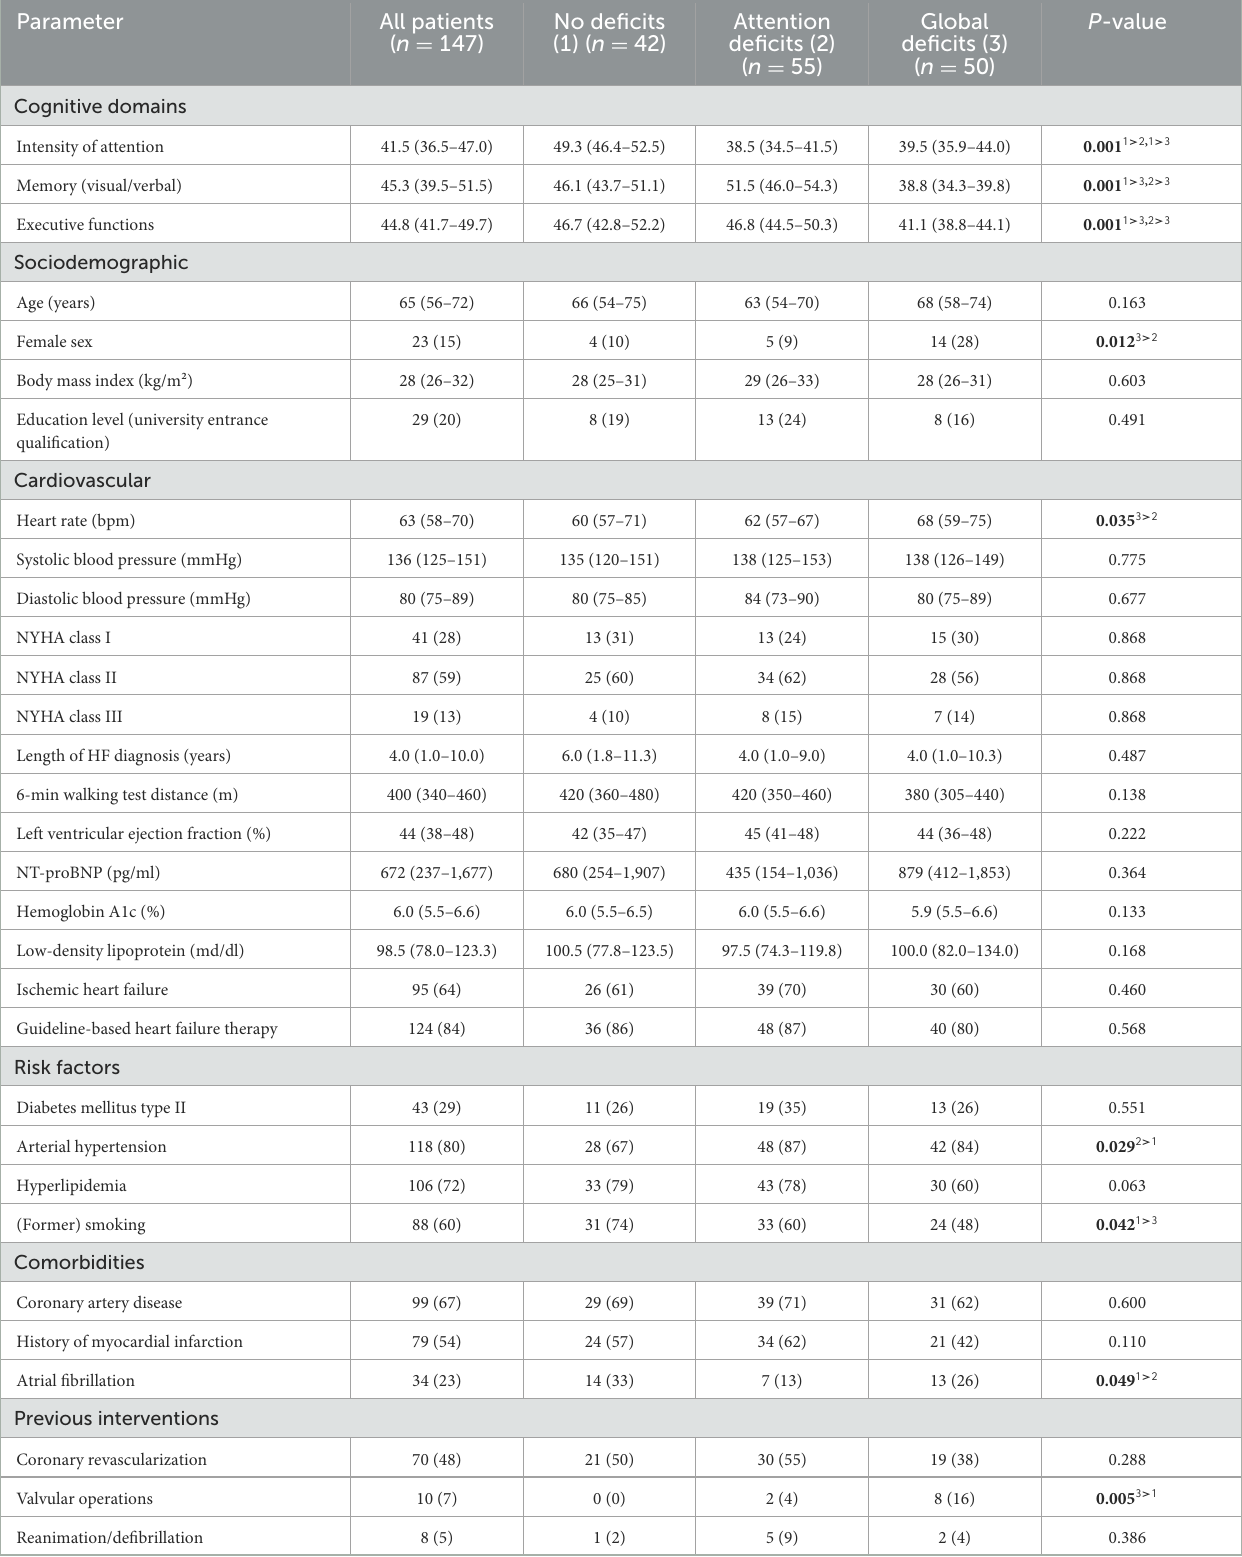
TABLE 2 Patient characteristics according to cognitive